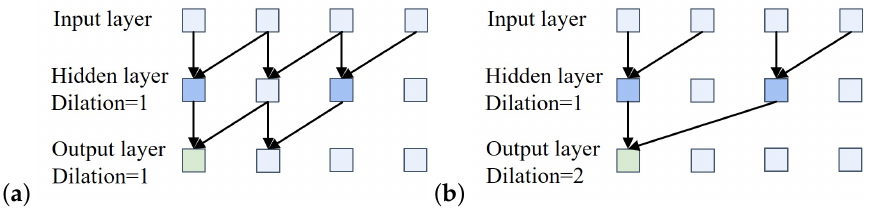
Figure 4. Structure of CNN and DCNN: ( a ) CNN; ( b ) DCNN.